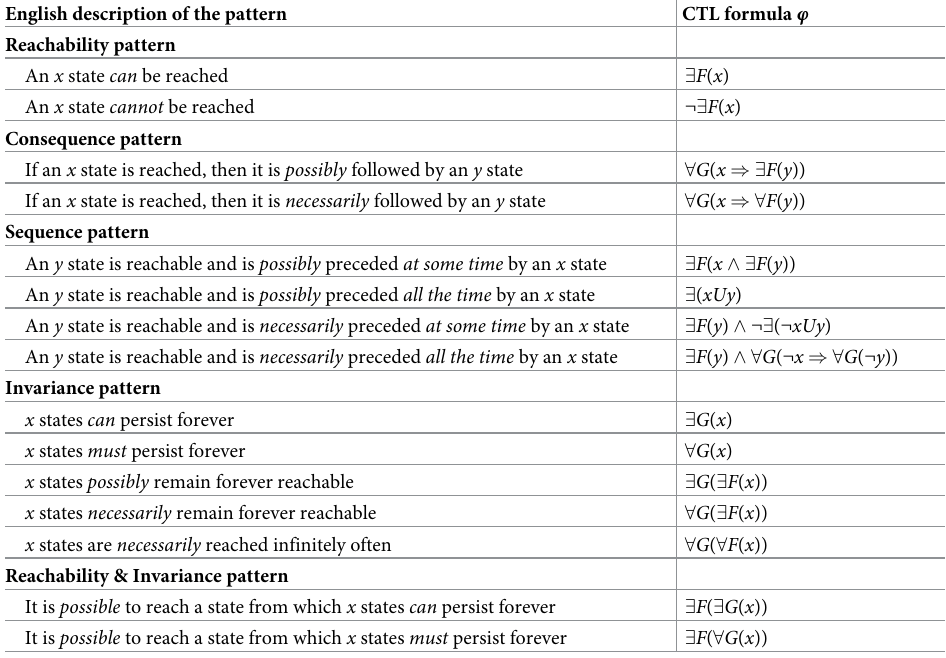
Table 2. Catalogue mapping query patterns to their translations in CTL. Dynamical properties relevant to ecological systems are gathered into patterns. The patterns are written in English and translated into CTL formulas. x and y are place-holders for state properties. (Adapted from